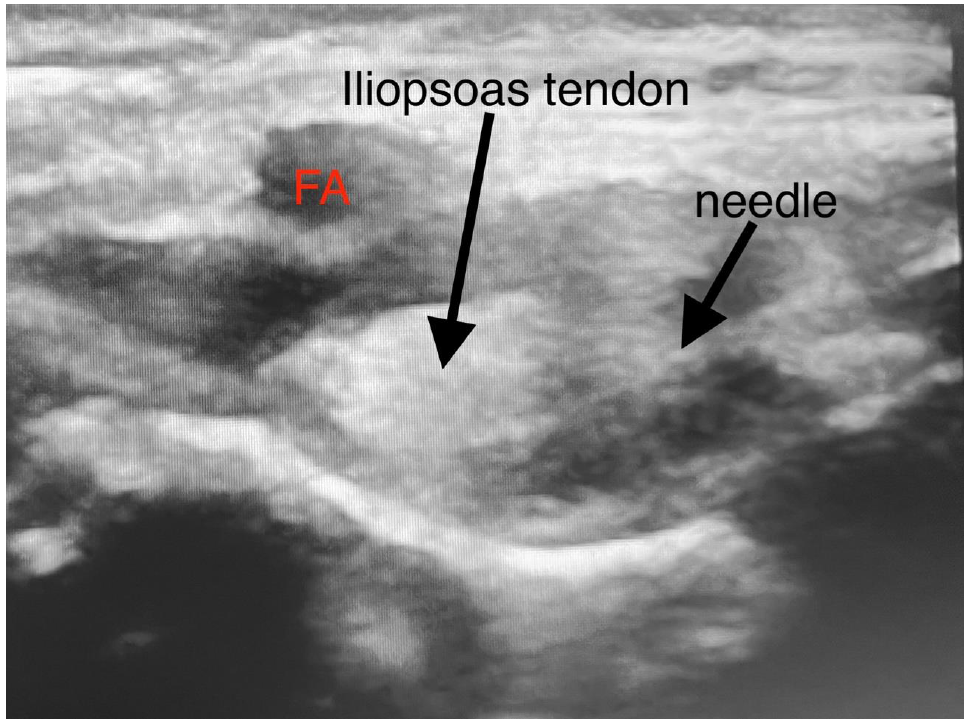
Figure 2. Injection technique of PENG block. (FA — femoral artery)